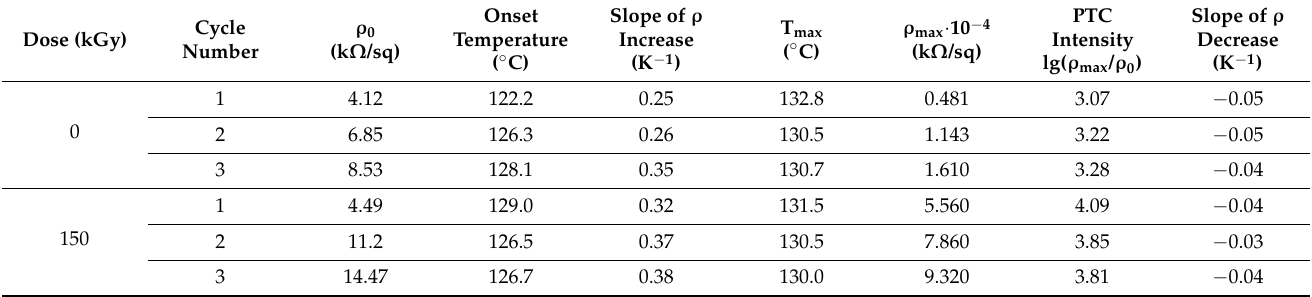
Table 3. Kinetic data of resistivity increase upon the heating of (CB + Gr)/(LLD + HD)